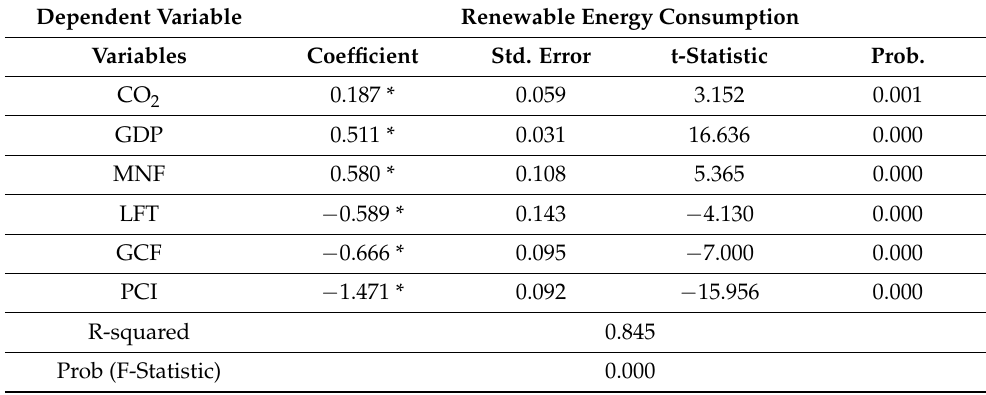
Table 6. Panel regression results for random-effects model.